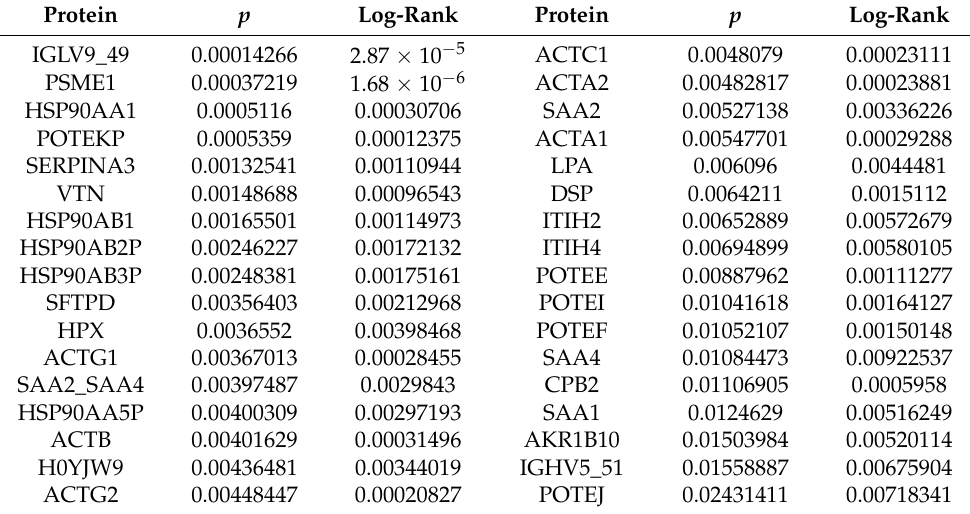
Table 2. Cox–Mantel log-rank tests and p -value estimates from Cox proportional hazards regression models.